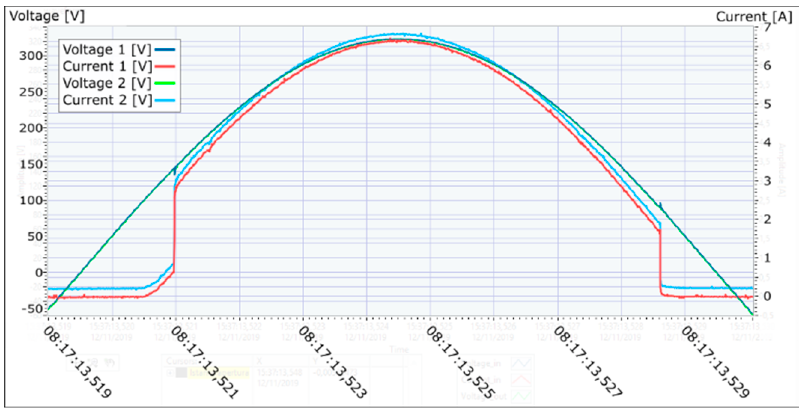
Figure 12. Deformation of the arc (using the Bourns 2049-12 surge arrester).